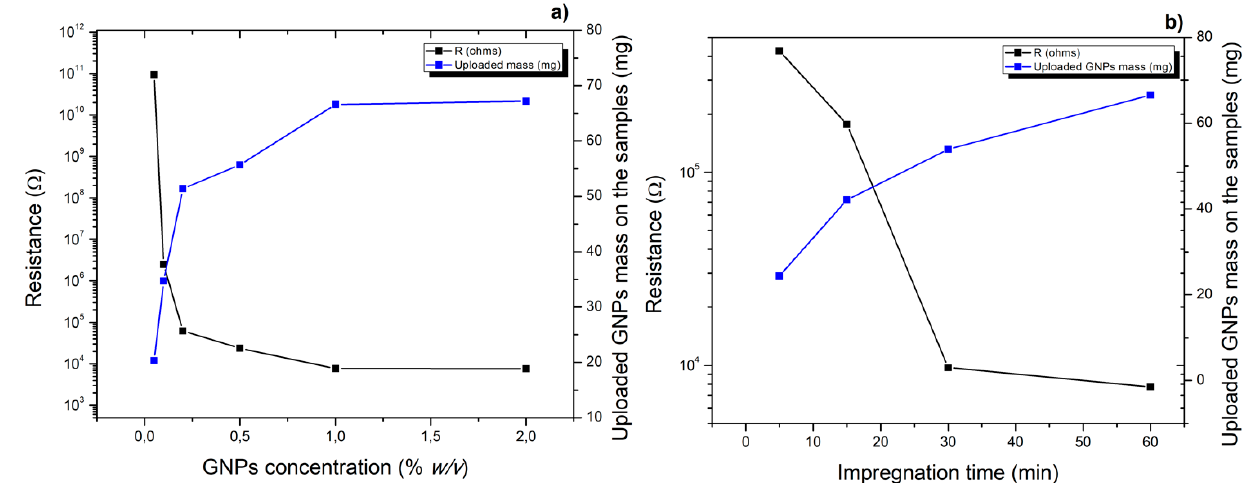
Figure 9. Electrical properties of the samples: ( a ) Resistance and uploaded GNPs mass of the GNPs-PCL membranes with an immersion of 1 h and after five consecutive washing/drying treatments; ( b ) Resistance and uploaded GNP mass for 1%GNPs-PCL membrane for several impregnation times (5 min, 15 min, 30 min, and 60 min).